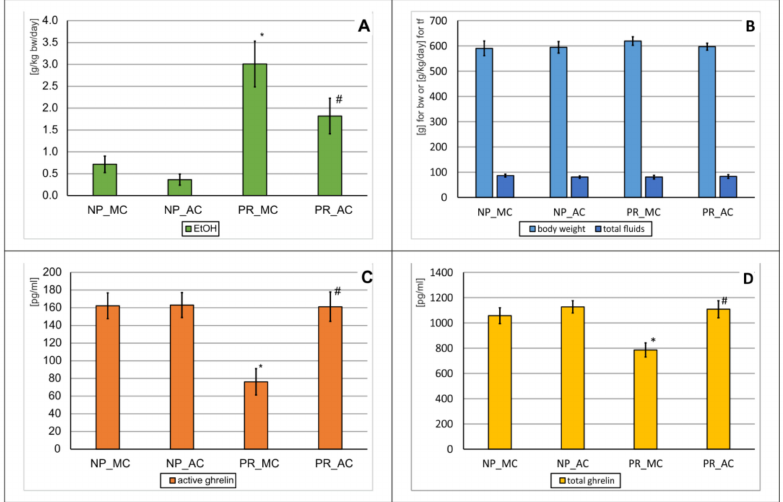
Figure 6. The effect of repeated (28 × ) acamprosate (AC) (500 mg/kg, p.o.) administration on alcohol drinking behavior, total fluid intake, body weight, and ghrelin levels in preferring (PR) and non- preferring (NP) rats. Legend: n = 7–10; mean ± SEM; PR_MC—control PR rats; NP_MC—control NP rats; MC—vehicle (0.5% methylcellulose); ( A ) amount of drunk ethanol [g/kg/day]; *—vs. NP_MC group, p < 0.001; #—vs. PR_MC group, p < 0.001; ( B ) body weight [g] and the total amount of fluid intake [g/kg/day]; ( C ) serum active ghrelin levels [pg/mL]; *—vs. NP_MC group, p < 0.001; #—vs. PR_MC, p < 0.001; ( D ) serum total ghrelin levels [pg/mL]; *—vs. NP_MC group, p < 0.001; #—vs. PR_MC, p <